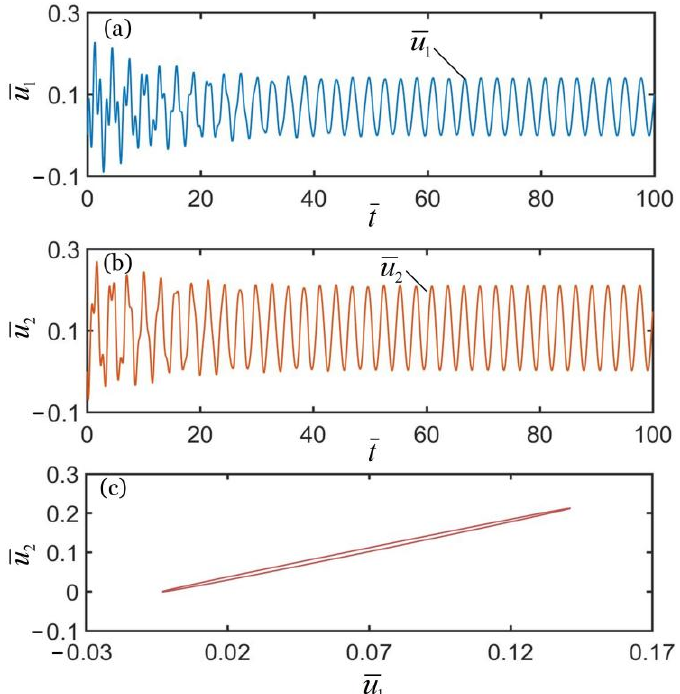
Figure 2. Time histories and domain of attraction of in-phase synchronous regime of light-powered LCE self-excited coupled oscillators for k 2 = 16. ( a ) u 1 vs. t ; ( b ) u 2 vs. t ; ( c ) domain of attraction. The two couple oscillators are in in-phase regime.